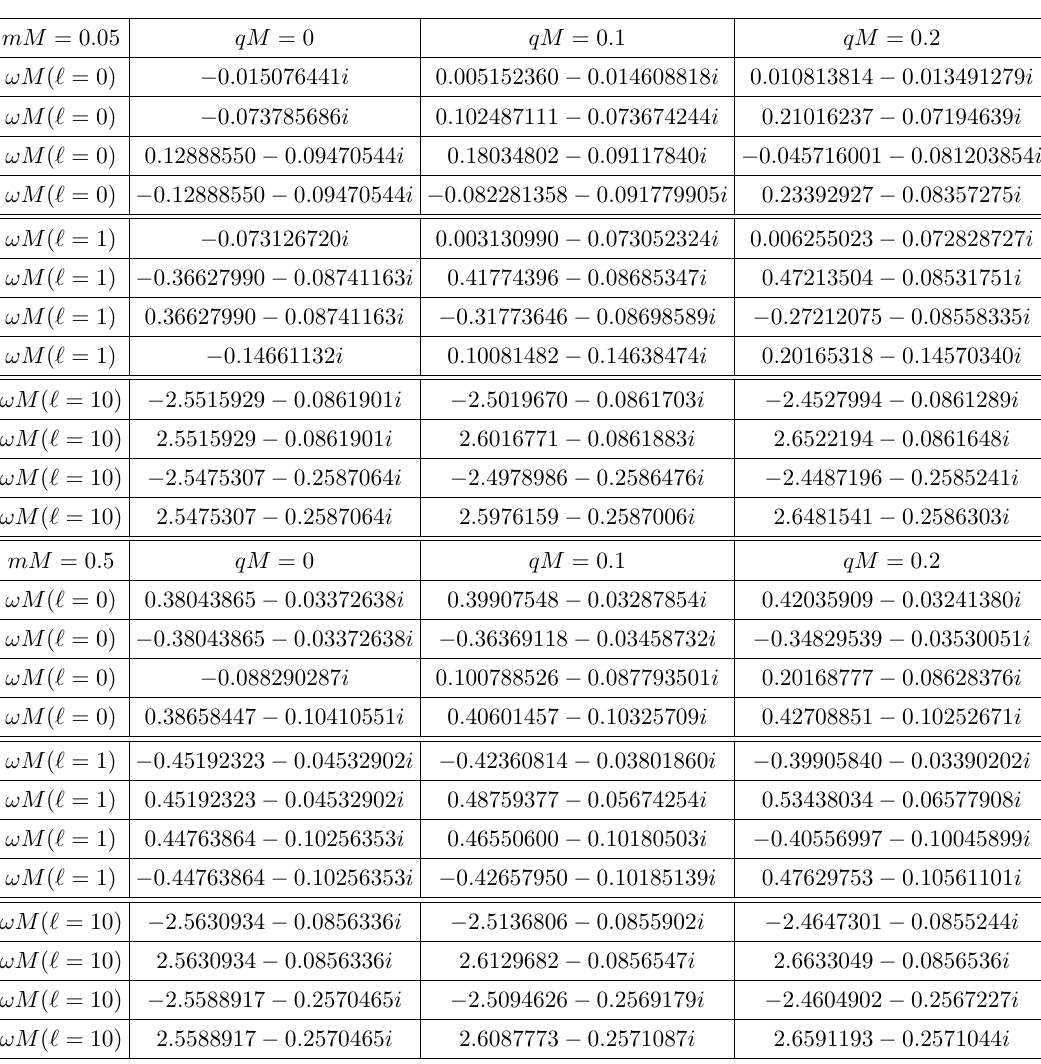
Table 15 . The QNFs ωM for massive scalar fields in the background of RNdS black holes with Λ M 2 = 0 . 01 , and different values of ‘ , and qM . Here, for Q/M = 0 . 999 , ∆ r/M ≈ 0 . 148